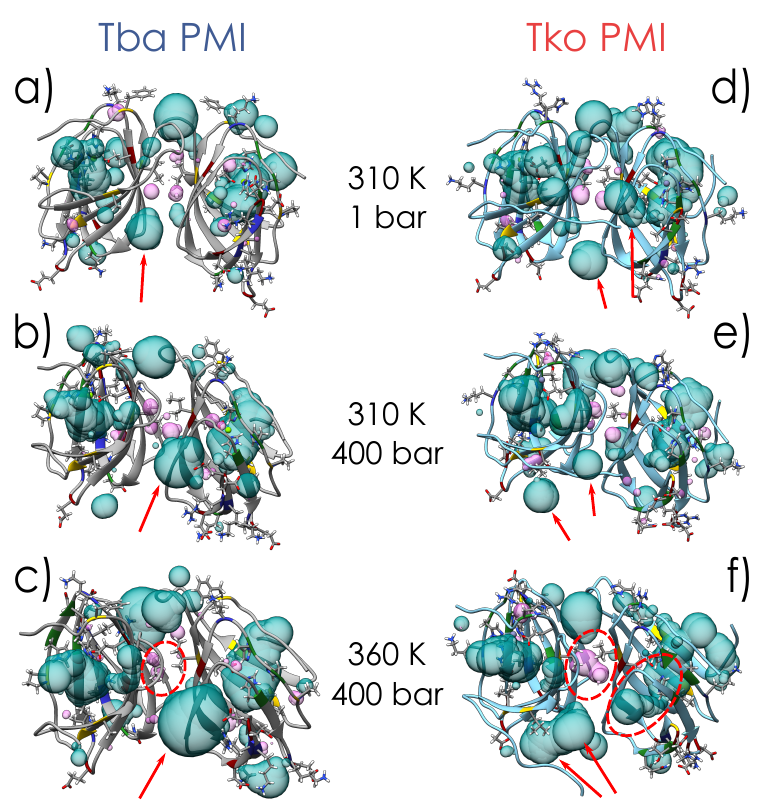
Figure 8. Representation of internal (magenta) and solvent-accessible (cyan) cavities for Tba PMI ( a – c ) and Tko PMI ( d – f ) at different T and P conditions. Structures are represented in cartoons, and substituted residues are evidenced in sticks (with the corresponding part of the ribbon coloured for residue type, blue for basic, red for acidic, green for polar and yellow for hydrophobic). Red arrows follow the evolution of some cavities, and the opposite behaviour of the internal cavities in the dimer interface of the two proteins is highlighted by red circles. Another red circle in ( f ) also shows how the ligand pocket in one monomer of Tko PMI has actually become a channel from side to side under extreme